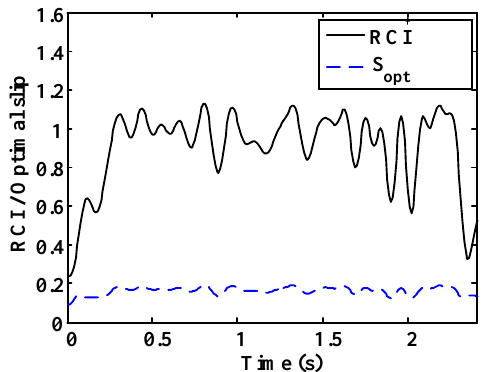
Figure 21. Dry asphalt: Estimated road condition and optimal slip.